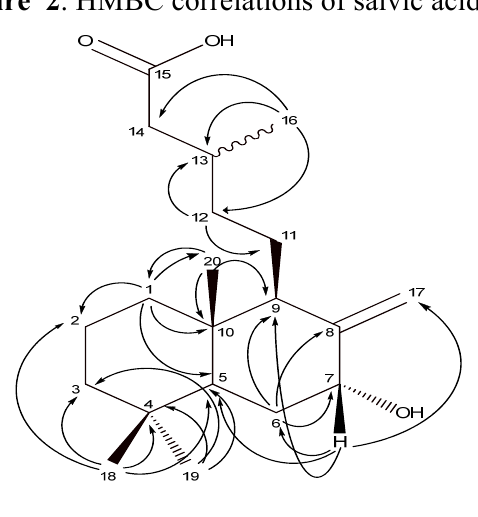
Figure 2 . HMBC correlations of salvic acid ( 1 ).